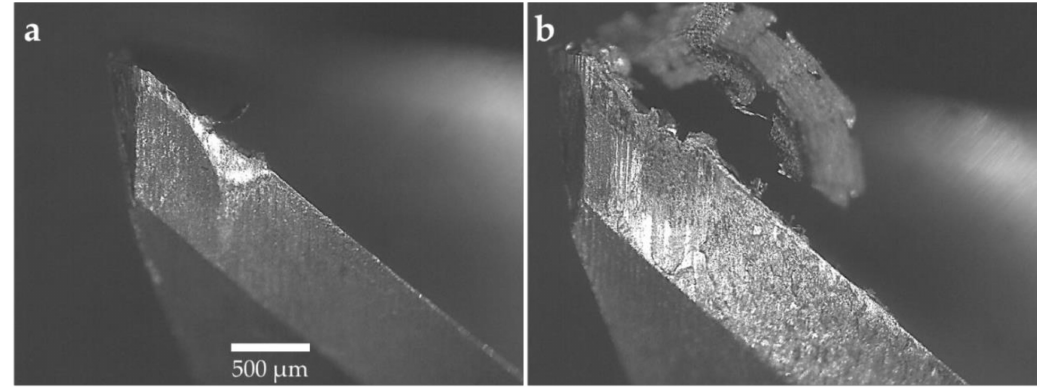
Figure 7. Micrographs of the tool with a 14 ◦ rake angle: ( a ) 10 ◦ primary clearance angle and ( b ) 8 ◦ primary clearance